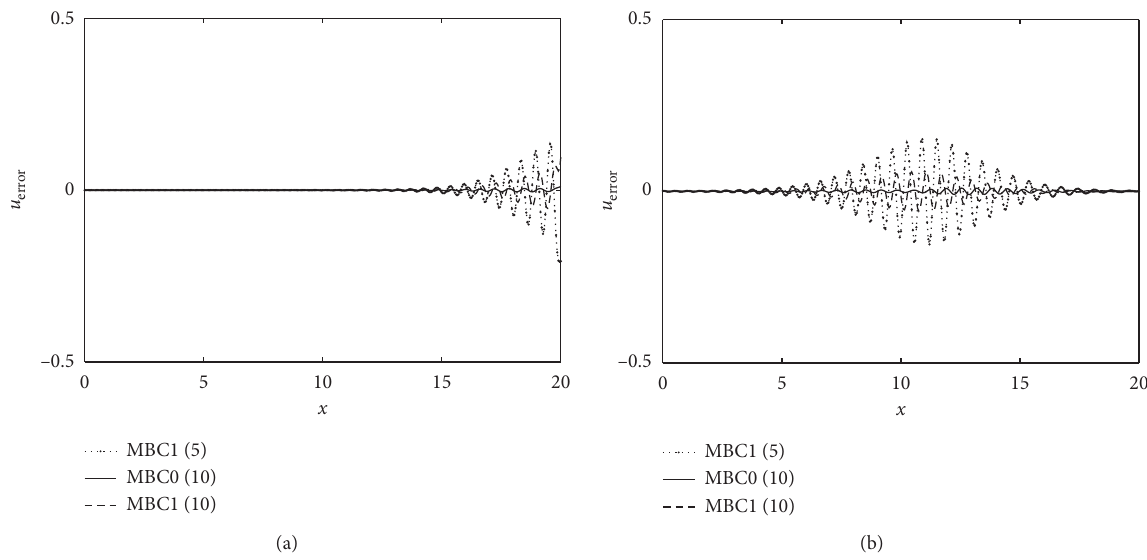
Figure 6: Error of displacement with the major wave number ( k ) � 10: (a) t � 1.0; (b) t � 1.5.